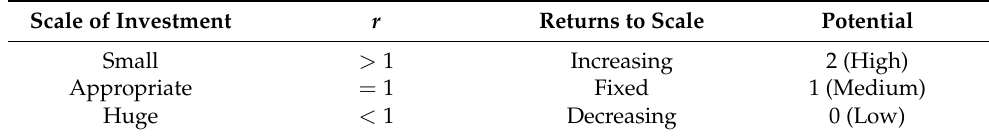
Table 1. The relationship of returns to scale and system potential. Scale of Investment r Returns to Scale Potential